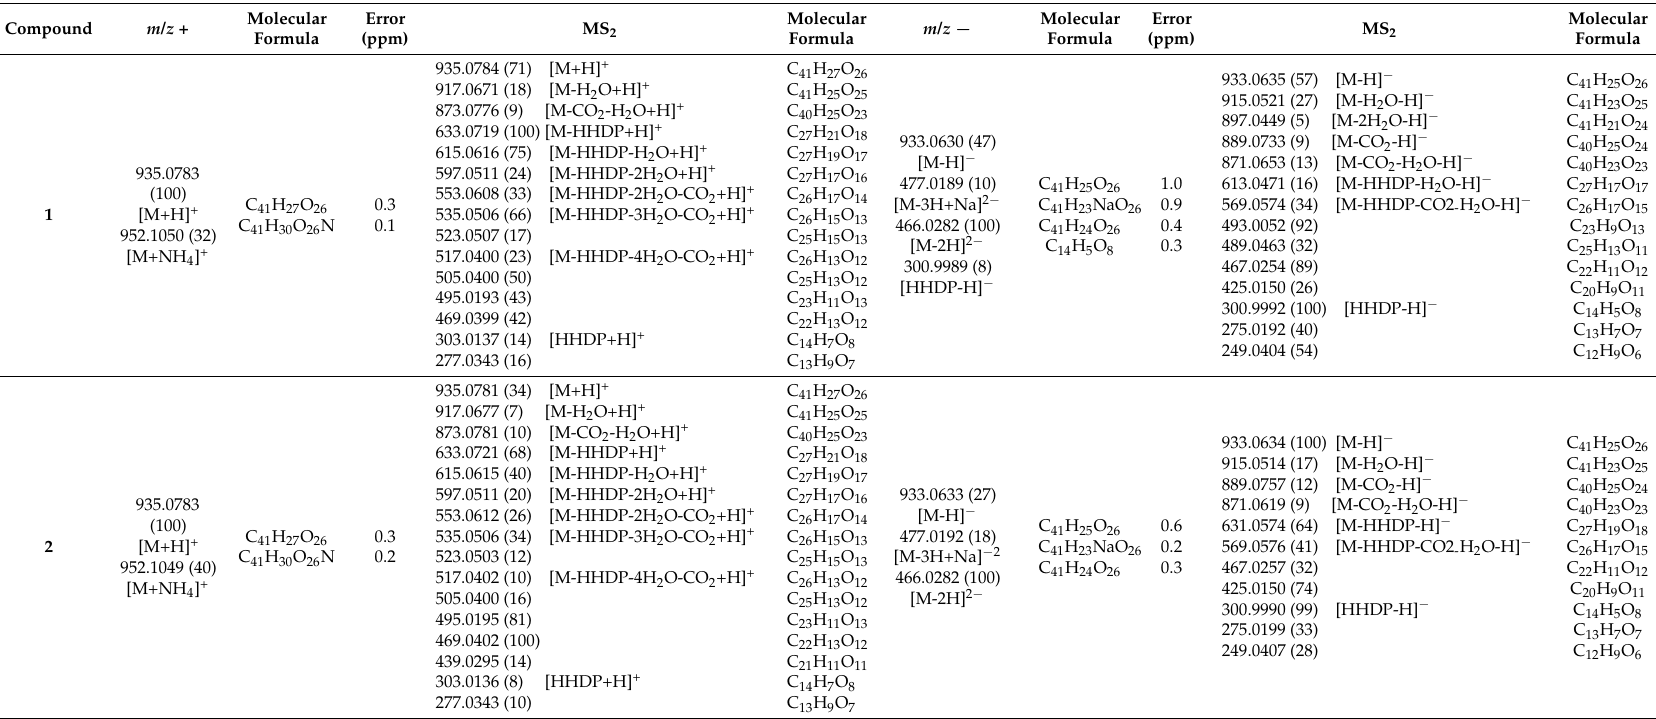
High-Resolution Mass Spectrometry (HRMS) and MS 2 data for compound 1 and compound 2 determined by ESI-Q-TOF analyses (HHDP, hexahydroxydiphenoyl unit = 302.0057 g · mol − 1 ). Ions with m / z in bold were isolated for fragmentation experiments in MS 2 . MS 2 ions without attribution were all singly charged